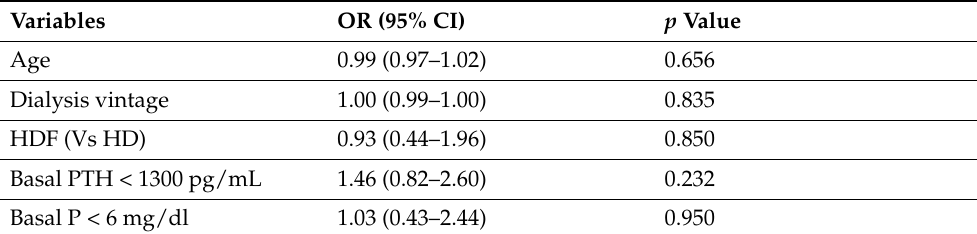
Table 5. Multivariate logistic regression to achievement of PTH reduction endpoint ≥ 30% at 6 months. OR, odds ratio; CI, confidence interval.